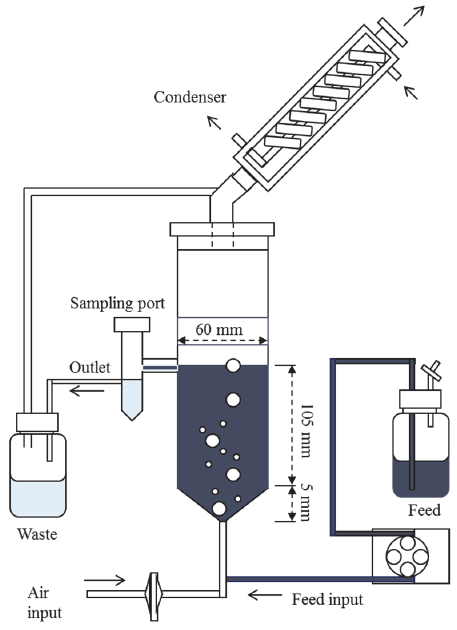
Figure 2. Diagram of the fixed-bed reactor used in the present study. The elements are not in scale.